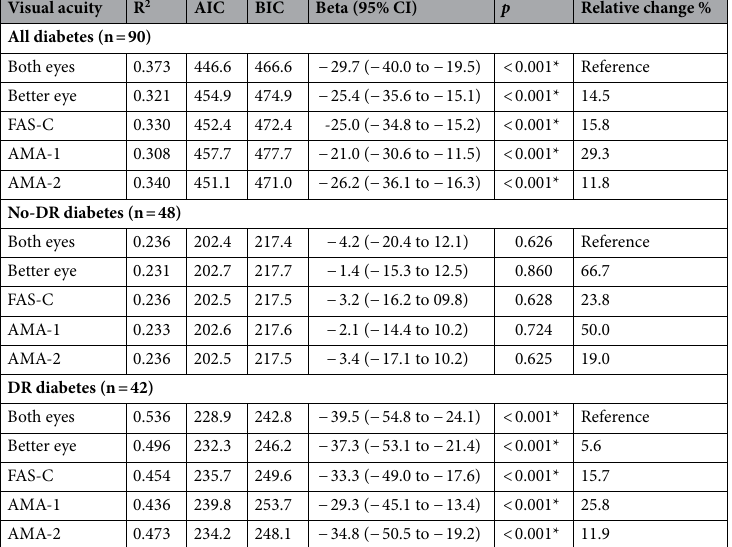
Table 3. Results of the multiple linear regression model and goodness-of-fit statistics of the different acuity models for the original NEI VFQ-25 composite scores. AIC Akaike information criterion, BIC Bayesian information criterion, DR diabetic retinopathy, FVS‑C functional acuity score developed by Colenbrander, AMA‑1 early version of FAS algorithm developed by the American Medical Association, AMA‑2 new version of FAS algorithm developed by the American Medical Association. *Indicates significant p values ( p < 0.05).